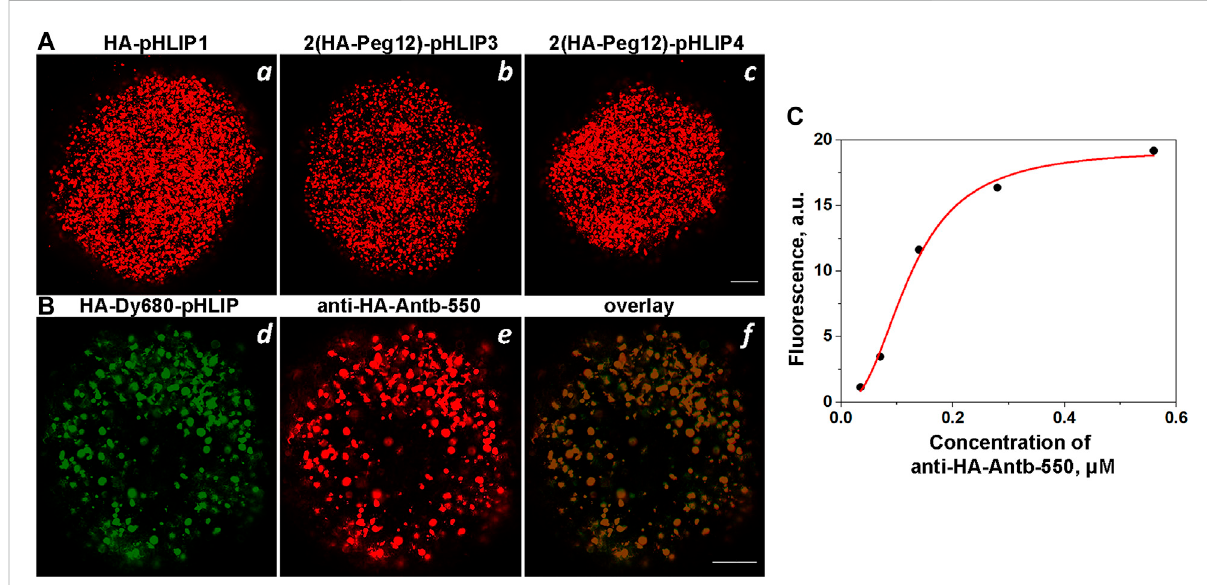
FIGURE 5 Binging of anti-HA-Antb with HA-pHLIP in tumor spheroids. (A) : HeLa tumor cell spheroids were treated with HA-pHLIP1 (a), 2(HA-Peg12)- pHLIP3(b)or2(HA-Peg12)-pHLIP4(c),followedbywashingandincubationwithanti-HA-Antb-550.Tumorspheroidswerethenwashedandimaged withaconfocalmicroscope. (B) HeLatumorspheroidsweretreatedwithHA-Dy680-pHLIP,followedbywashingandincubationwithanti-HA-Antb- 550.Tumorspheroidswerethenwashedandimagedusingdifferentchannelstovisualize fl uorescentHA-pHLIP(d),boundanti-HAantibody(e) andtheiroverlay(f)byconfocalmicroscopyusing×10and×20objectives.100- μ mscalebarsareshowninallpanels. (C) Titrationcurve:HeLatumor spheroids treated with 1 µM of HA-pHLIP1 followed by washing were then treated with increasing concentrations of anti-HA-Antb-550, the mean fl uorescence intensities per area were calculated and are shown vs. the concentration of